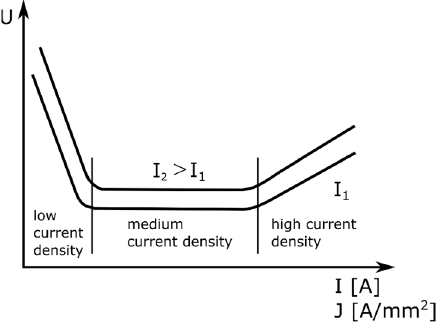
Figure 2. Static characteristics of an electric arc.